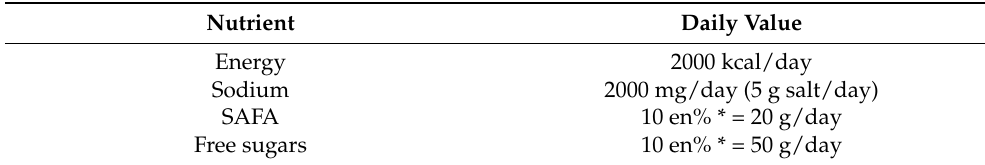
Table 1. Daily values used based on WHO guidelines. Nutrient Daily Value Energy 2000 kcal/day